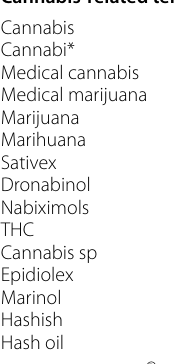
Table 2 Search strategy: MeSH terms are bolded Embase (Embase Classic Embase 1947 to 2017 week 41) + Dementia-related